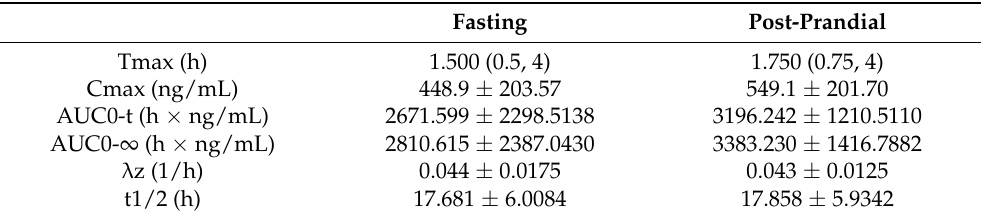
Table 6. The pharmacokinetic parameters of DP (mean ± SD) in healthy Chinese volunteers.